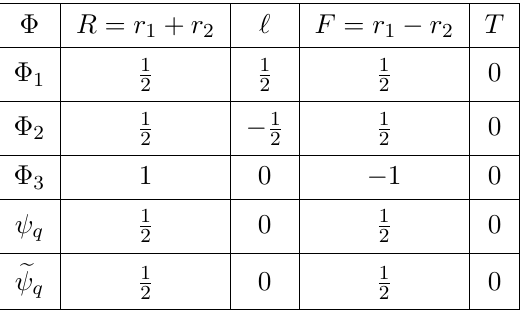
Table 2 . Charge assignments of the N = 2 chiral multiplets in the ADHM